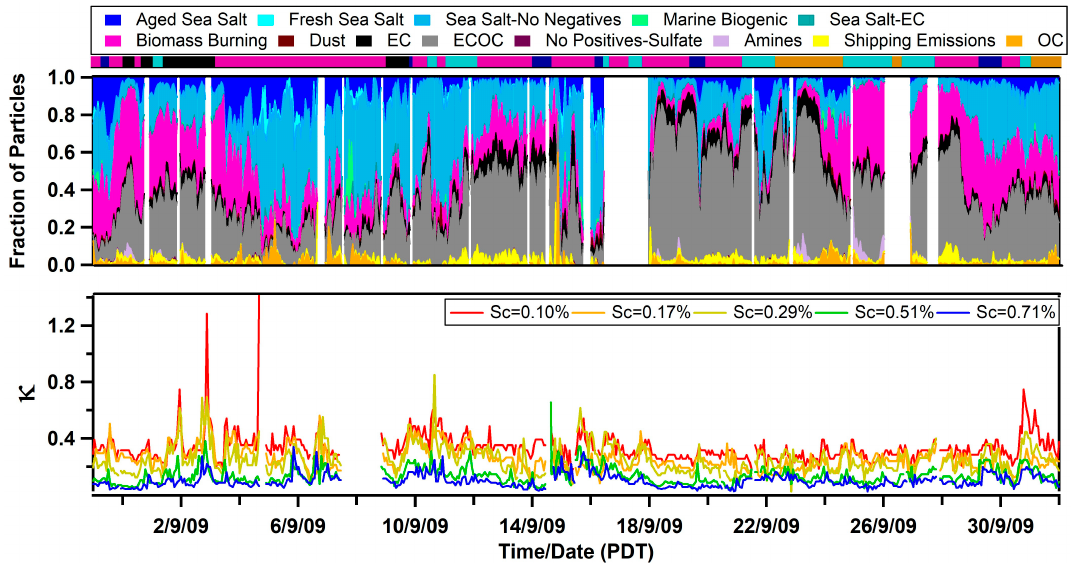
Figure 2. Temporal profile of the hygroscopicity parameter, κ , as a function of S crit (S c , bottom panel ), the submicron single-particle composition measured by the ATOFMS ( middle panel ), and the airmass classification ( top panel , magenta is Mixed Coastal, black is Southerly/Mexico, cyan is Los Angeles/Long Beach, orange is Inland, and dark blue is Oceanic).